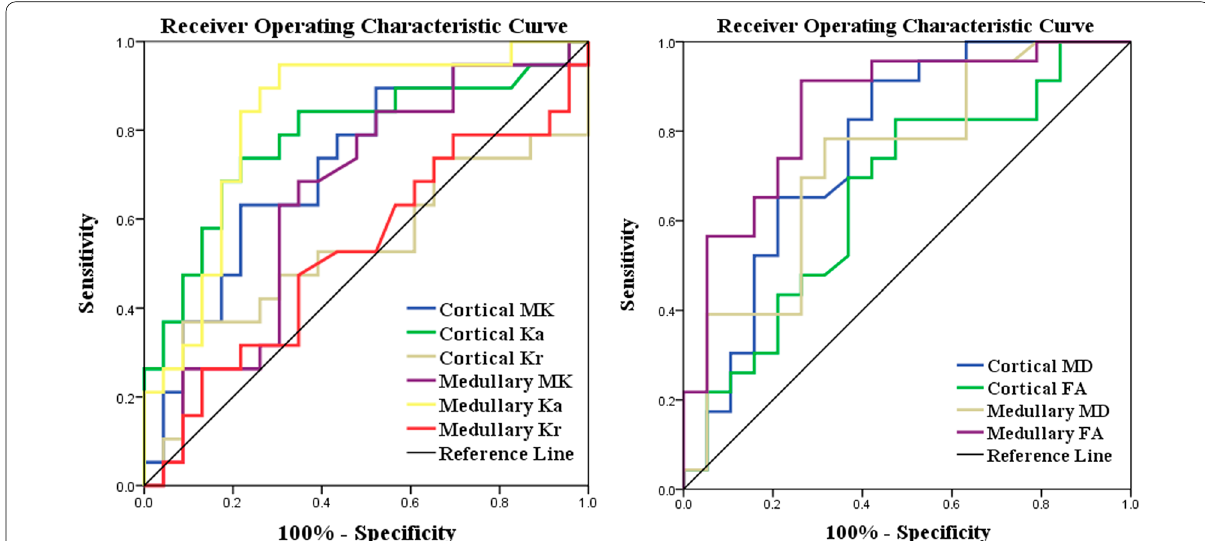
Fig. 6 Receiver operating characteristic (ROC) curves of the DKI metrics in discriminating stable renal function from impaired renal function. ROC curves of medullary FA in assessing the degrees of renal dysfunction generated the highest area under the curve (AUC, 0. 955) among DKI metrics